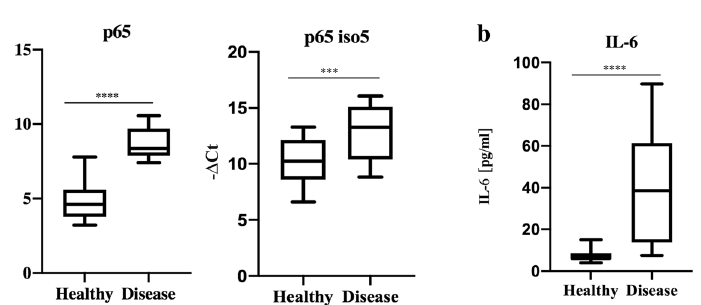
Figure 6. mRNA relative quantity of p65 and p65 iso5 and level IL-6 in blood. ( a ) The Ct and median measuring gene expression levels of p65 and p65 iso5 in PBMC of SARS-CoV-2 and in control patients. The p65 and p65 iso5 mRNA are significantly up-regulated in patients with SARS-CoV-2 compared to control samples. ( b ) IL-6 levels and median measured in patients with SARS-CoV-2 compared to healthy patients. In ( a , b ) data are presented as mean ± SEM. ****< 0.001 and ***< 0.005 in comparison to control